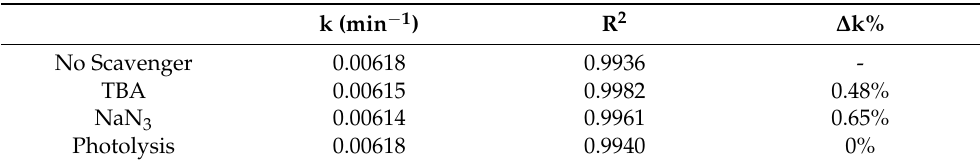
Table 1. Removal kinetic constants (k), correlation coefficients (R 2 ) and degree of reduction of the removal kinetic constants (% ∆